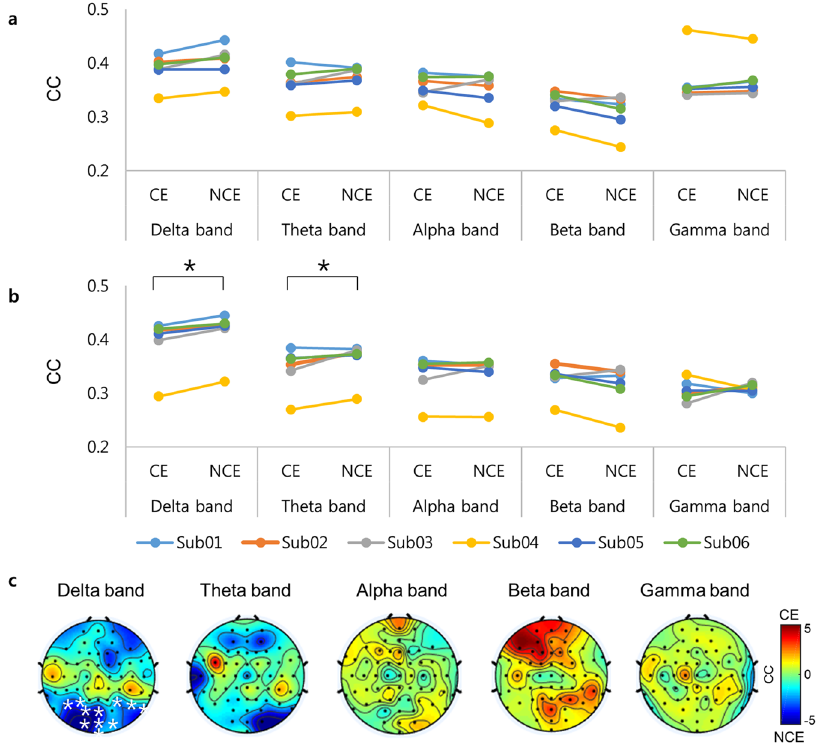
Figure 3. Local network properties of CE and NCE based on PLV. The clustering coefficients in the ( a ) frontal and ( b ) parietal regions in the studied frequency bands for all subjects. Black asterisks indicate significant differences in the mean clustering coefficient between CE and NCE according to MTPC. ( c ) Topographies of the differences in the local processing (clustering coefficient) between CE and NCE. The colors indicate the t -value of the difference between CE and NCE. Red regions indicate that the clustering coefficient is stronger in CE than in NCE, whereas blue regions indicate that the clustering coefficient is stronger in NCE than in CE. White asterisks indicate channels with significant differences between CE and NCE according to SnPM. SnPM = statistical non-parametric mapping; CC = clustering coefficient; CE = conscious experience; NCE = no conscious experience; PLV = phase-locking